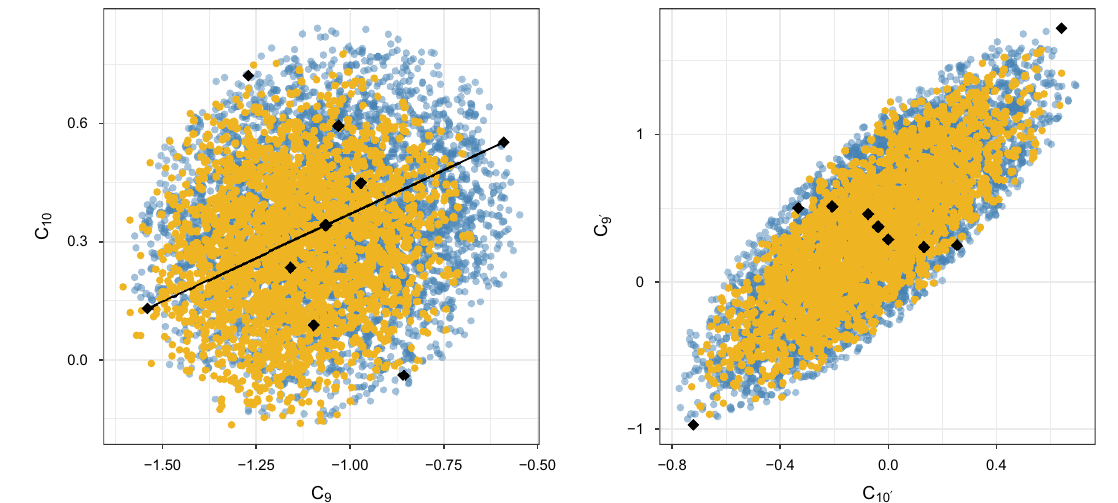
Fig. 12 Samplepointsrepresentingthequadraticapproximation(blue) and the full fit (yellow), together with the 12 SVD points, projected onto − C C 9 − C 10 (left) and C (right). The line in the left plot connects 9 (cid:3) 10 (cid:3) the SVD points in direction 5, illustrating how the asymmetric shape of